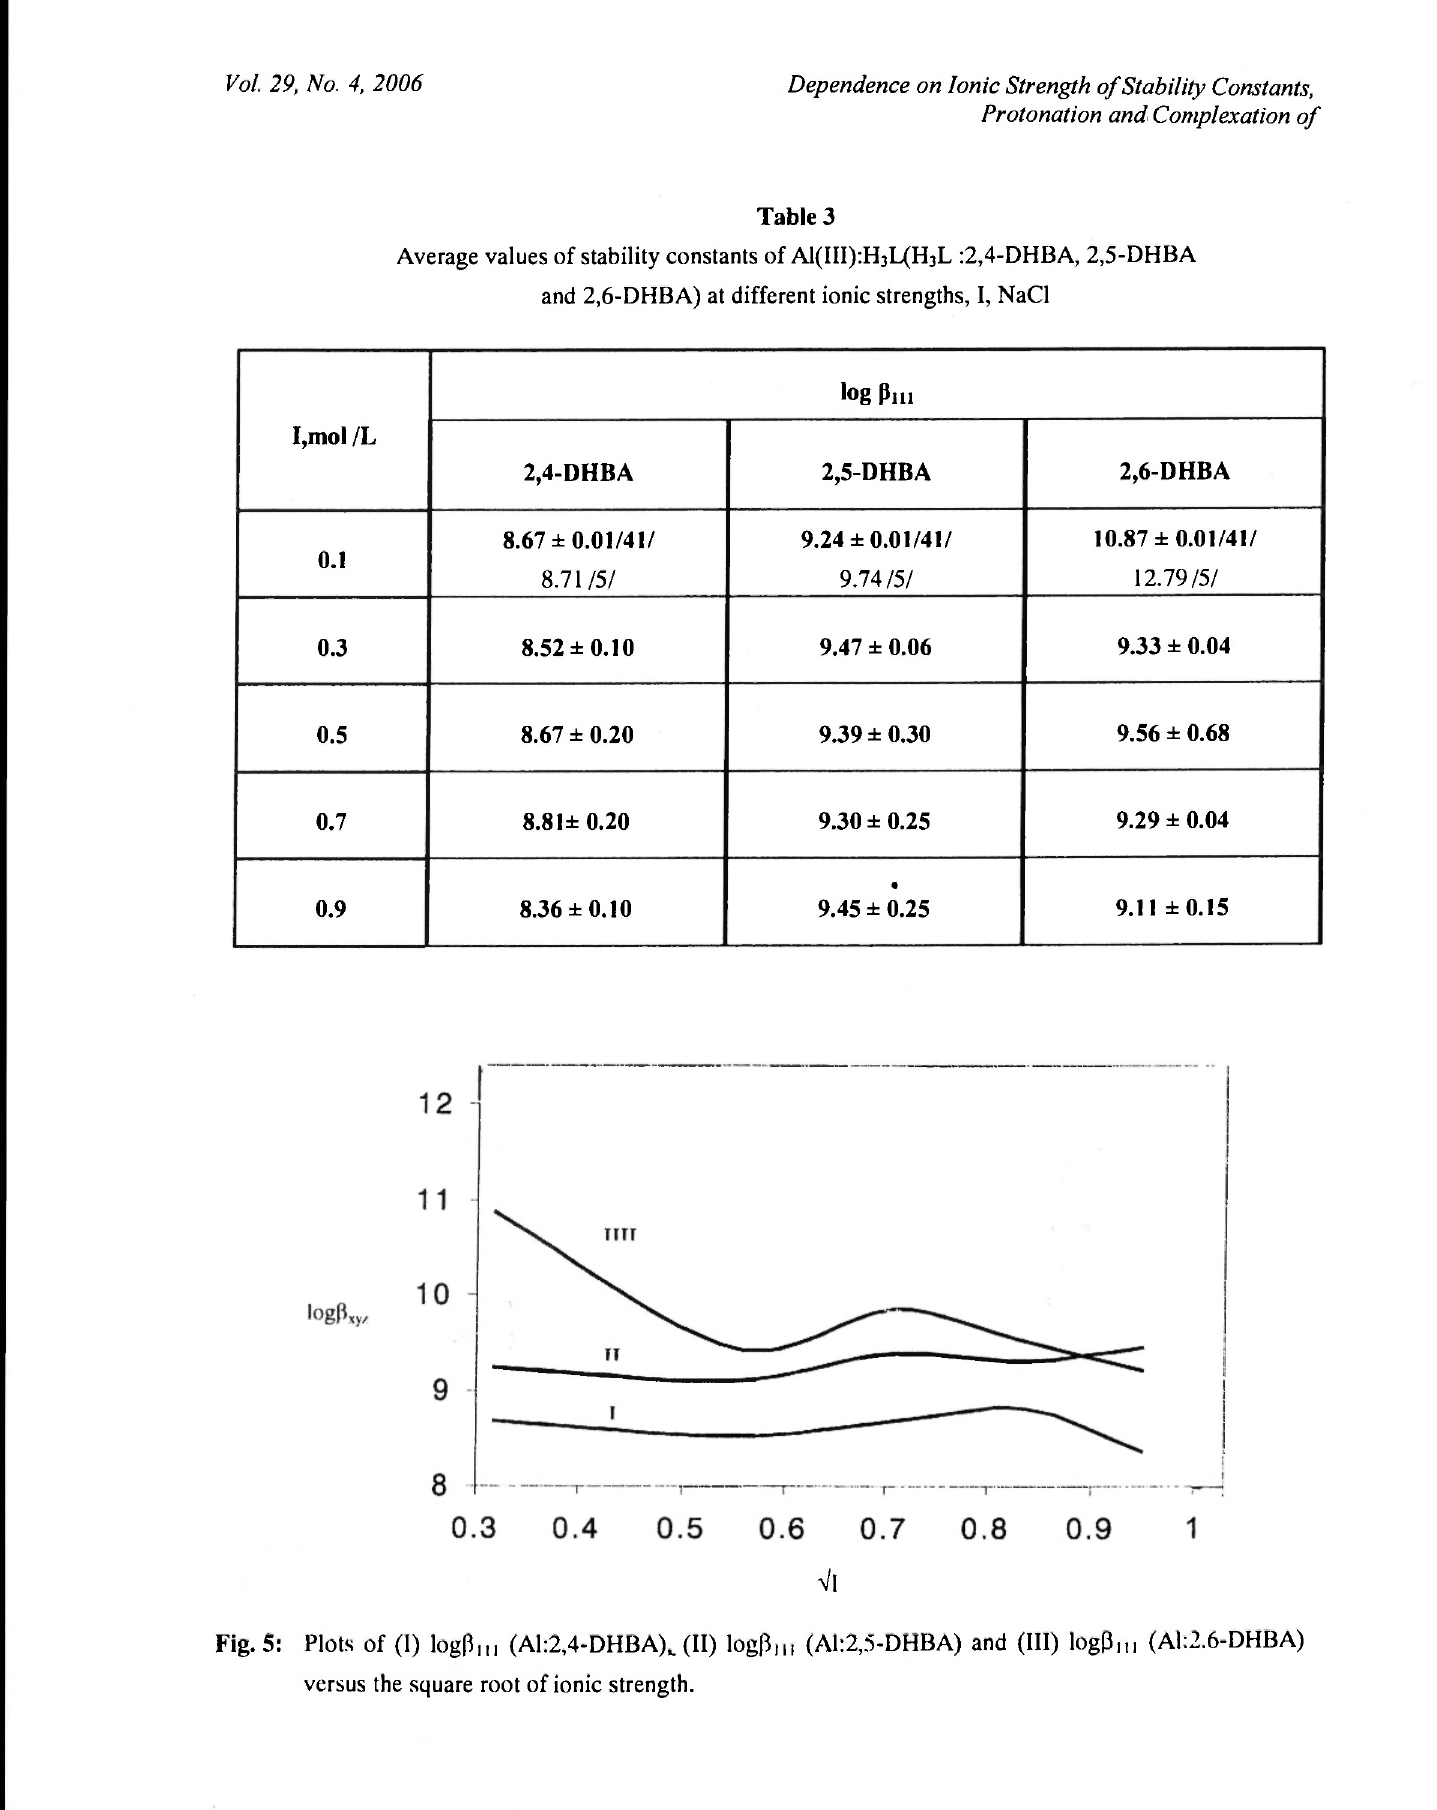
Fig. 5: Plots of (1) logß m (Al:2,4-DHBA) t (II) logß m (A1:2,5-DHBA) and (III) logß m (A1:2.6-DHBA) versus the square root of ionic